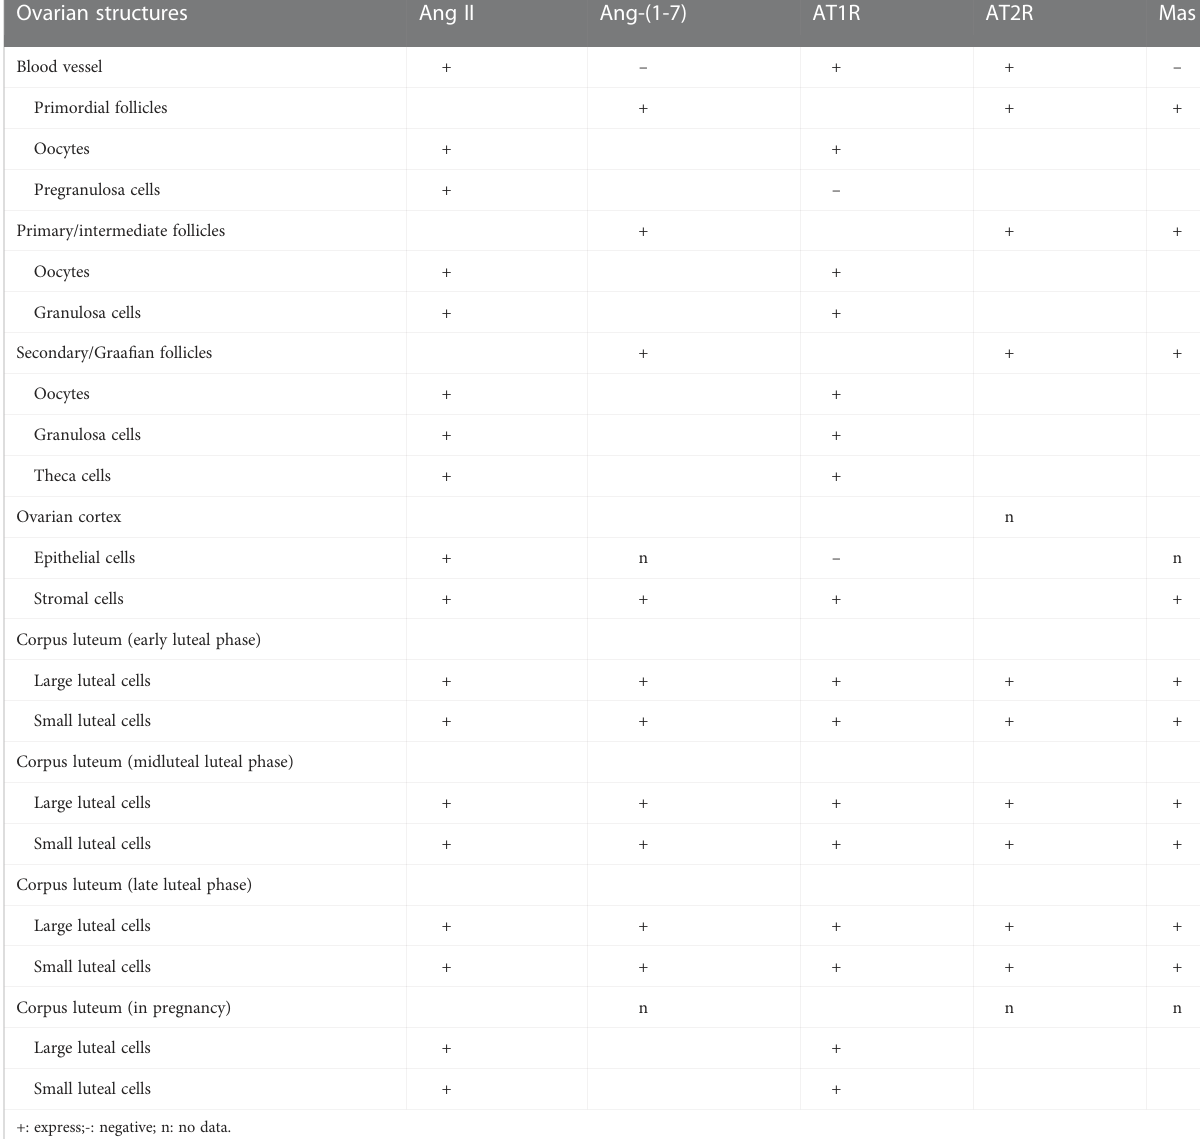
TABLE 1 Expression status of RAS components in different parts of ovary. Ovarian